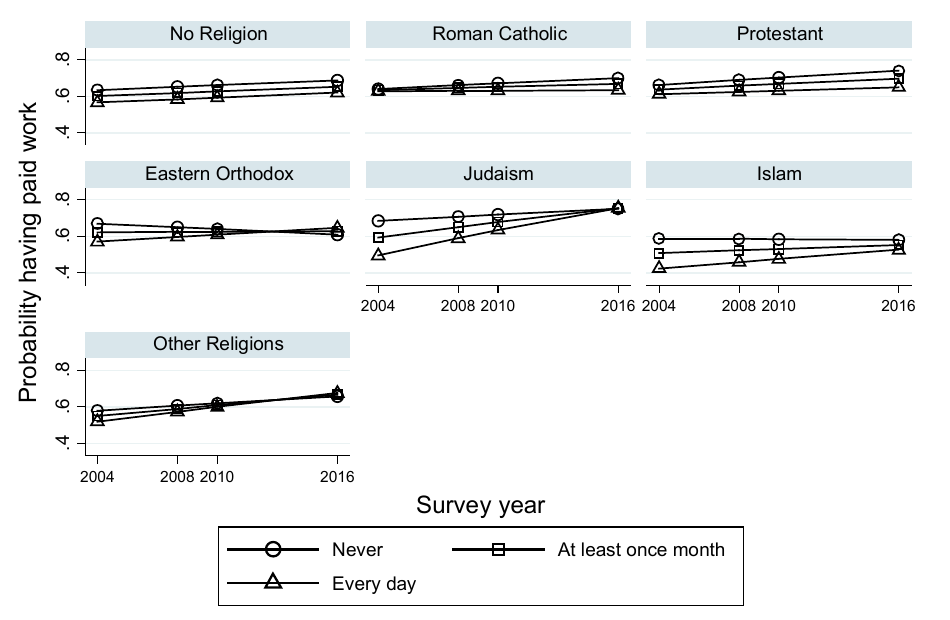
Figure 3 : Average predicted probabilities from model results. Effects of religiosity (“ How often do you pray apart from at religious services? ”) on the employment of women belonging to different religions between 2004 and